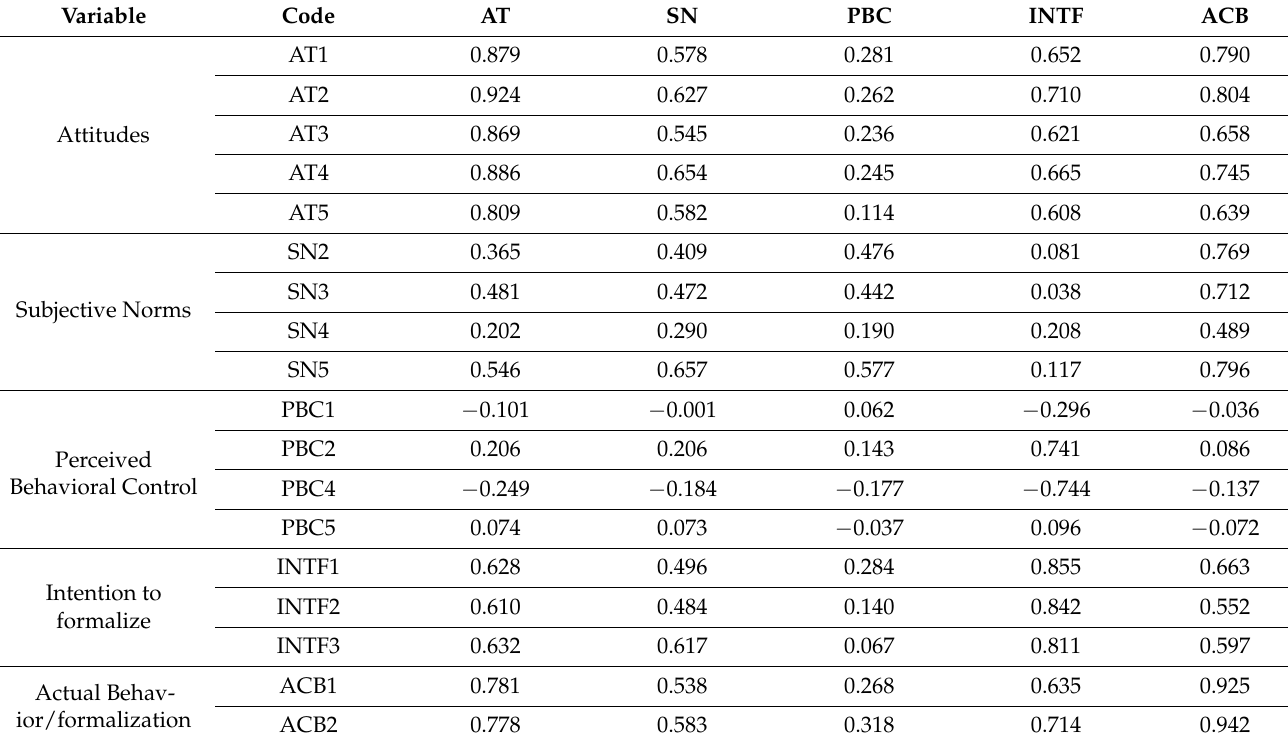
Table 5. Indicator item cross-loading. Attitudes (AT), Subjective Norms (SN), Perceived Behavioral Control (PBC), Intentions to Formalize (INTF), and Actual Behavior/formalization (ACB).